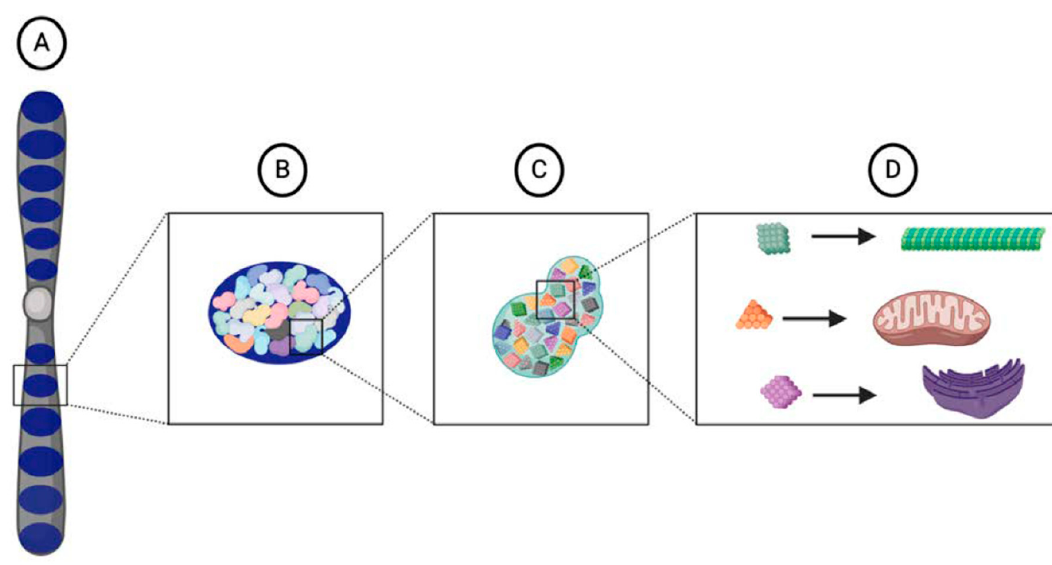
Figure 1. Illustration of Weismann’s vital units. Each chromosome, or idant ( A ), is composed of several ids (dark blue) ( B ) that are inherited intact from the parental germ cells within the germ plasm. Each id is composed of determinants ( C ) that are arranged in a particular architecture. Each determinant corresponds to a specific cell type in an organism and contains a particular assemblage of biophors ( D ), a group of molecules that, when released from the nucleus and into the cytoplasm, provide the starting material from which cellular components develop.